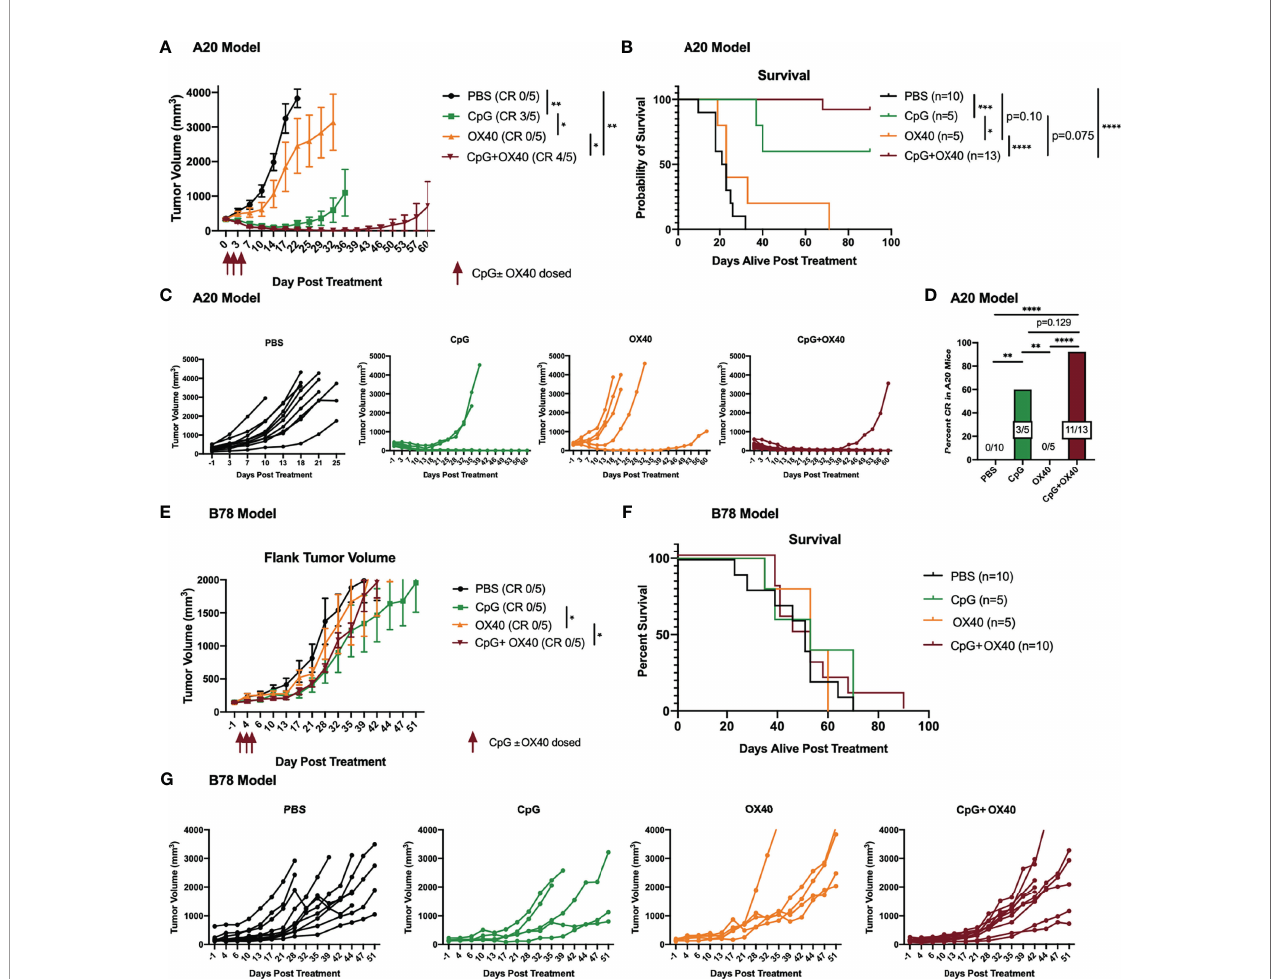
FIGURE 1 | CpG+OX40 In Situ Vaccine Cures Mice of A20 Lymphoma but Fails to Cause Tumor Regression in B78 Melanoma. (A) Average tumor volume plots (+/- standard error of the mean) from one representative experiment, and (B) combined overall survival in the A20 model showing group responses to PBS (black), CpG (green), OX40 (yellow), and CpG+OX40 (red). The number of mice that were cured of their tumor burden in (A) are shown in parentheses (CR). The anti-tumor response of CpG alone and OX40 alone were tested in one experiment (in A ), while the strong anti-tumor response of CpG+OX40 in the A20 model was tested in two independent experiments [shown together in (B) ]. (C) Combined individual animal tumor growth plots for each animal shown in (A, B) . (D) The percent of A20 tumor bearing mice in B that were cured of their tumor burden following treatment with PBS, CpG, OX40, and CpG+OX40. (E) Tumor volume plots (+/- standard error of the mean) from one representative experiment, and (F) overall survival in the B78 model showing group responses to PBS (black), CpG (green), OX40 (yellow), and CpG+OX40 (red). The number of mice that were cured of their tumor burden in E are shown in parentheses. The anti-tumor response of CpG alone and OX40 alone were tested in one experiment in (E) , while the lack of anti-tumor response of CpG+OX40 in the B78 model was tested in two independent experiments [shown together in (F) ]. (G) Individual tumor growth curves of mice in E showing responses to PBS (black), CpG (green), OX40 (yellow), and CpG+OX40 (red) in the B78 model. Red arrows shown in (A, E) indicate the days CpG and/or OX40 were dosed IT (d. 0, 2, 4). In both tumor models, n=5-8 per group per experiment. P values for average tumor volume plots calculated using time-weighted average analysis. P values for overall survival calculated via log rank test. P values for CR rates calculated via one-way ANOVA. *P ≤ 0.05; **P ≤ 0.01; ***P ≤ 0.001; ****P ≤